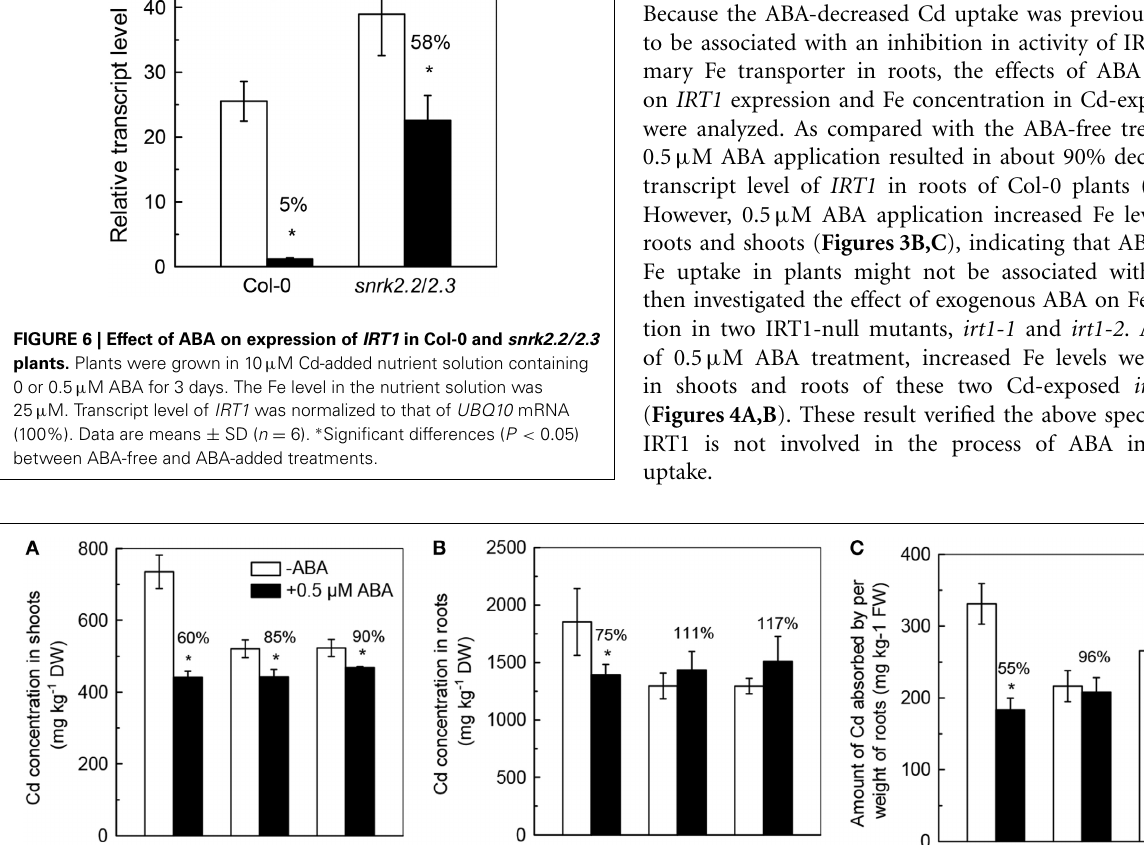
Cd concentrations. (B) Root Cd concentrations. (C) Amount of Cd absorbed by per weight of roots. Data are means ± SD ( n = 5). ∗ Significant differences ( P < 0 . 05) between ABA-free and ABA-added